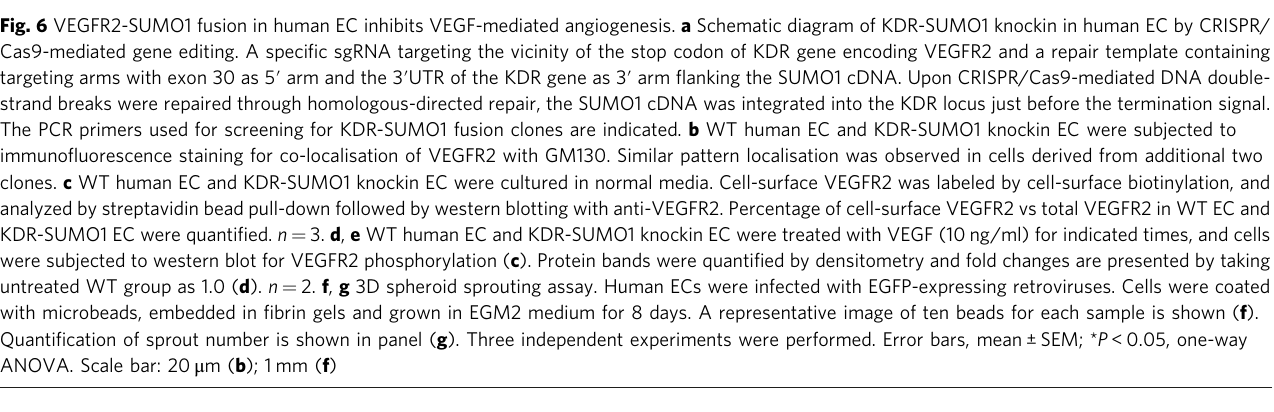
Fig. 6 VEGFR2-SUMO1 fusion in human EC inhibits VEGF-mediated angiogenesis. a Schematic diagram of KDR-SUMO1 knockin in human EC by CRISPR/ Cas9-mediated gene editing. A speci fi c sgRNA targeting the vicinity of the stop codon of KDR gene encoding VEGFR2 and a repair template containing targeting arms with exon 30 as 5 ′ arm and the 3 ′ UTR of the KDR gene as 3 ′ arm fl anking the SUMO1 cDNA. Upon CRISPR/Cas9-mediated DNA double- strand breaks were repaired through homologous-directed repair, the SUMO1 cDNA was integrated into the KDR locus just before the termination signal. The PCR primers used for screening for KDR-SUMO1 fusion clones are indicated. b WT human EC and KDR-SUMO1 knockin EC were subjected